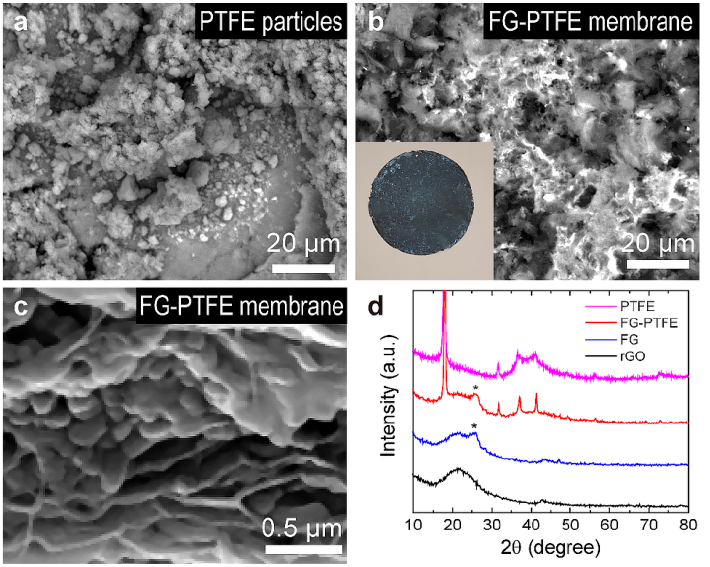
Figure 2. Morphology of PTFE-containing samples, and the XRD patterns. ( a ) SEM image of PTFE particles. ( b ) SEM image and photograph of an FG-PTFE membrane. ( c ) SEM cross-sectional image of an FG-PTFE membrane. ( d ) XRD patterns of rGO, FG, FG-PTFE, and PTFE.